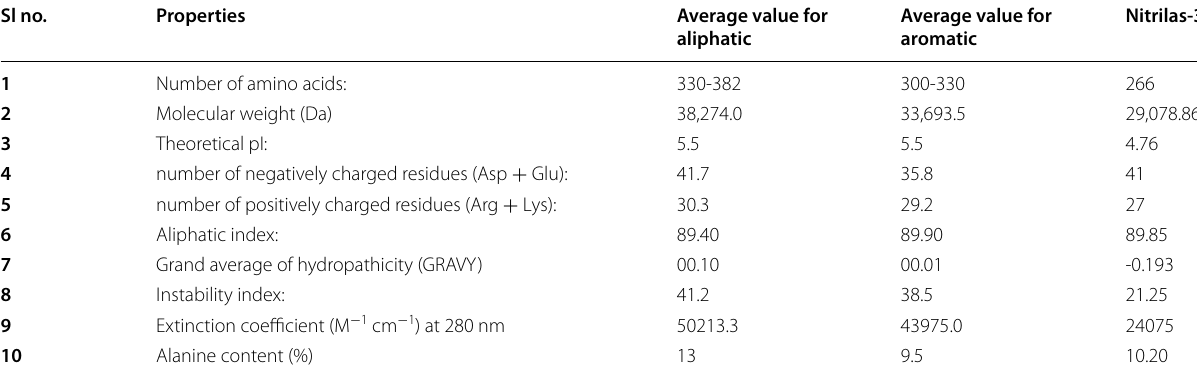
Table 2 Comparison of physicochemical parameters of nitrilase-3 protein with aliphatic and aromatic nitrilase Sl